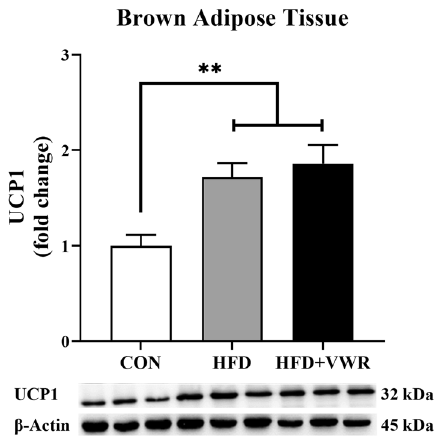
Fig. 5 Effects of chronic HFD and VWR exercise on UCP1 in brown adipose tissue (BAT). Values are shown as mean